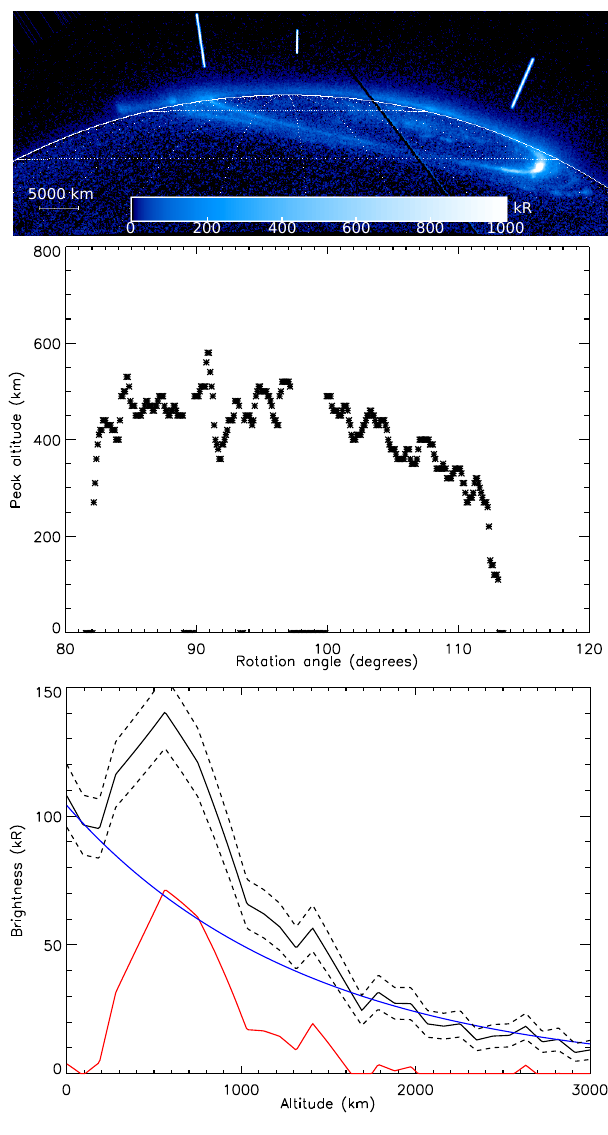
Figure 1. Top panel: example of an ACS image, acquired with the F125LP filter on 6 June 2007. The main emission is clearly seen above the limb. The two long lines indicate the limits of the scan and the small one indicates the location of the selected profile. Mid- dle panel: profile of the peak altitude as a function of the rotation scan angle (stars); 0 ◦ corresponds to the dawn equator and 90 ◦ cor- responds to the North Pole. Bottom panel: example of an extracted vertical profile (solid black line), along with the associated uncer- tainty (dashed lines). The blue line represent the best fit background profile and the red line represents the resulting vertical auroral pro-